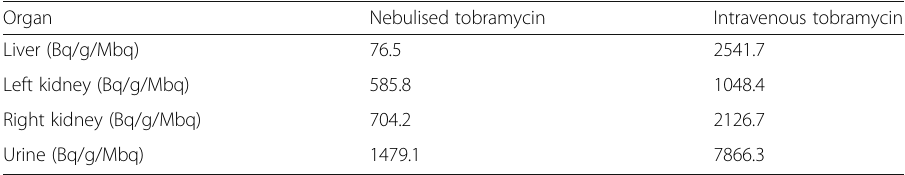
Table 3 Quantitative extra-pulmonary tissue radioactivity concentrations Organ Nebulised tobramycin Intravenous